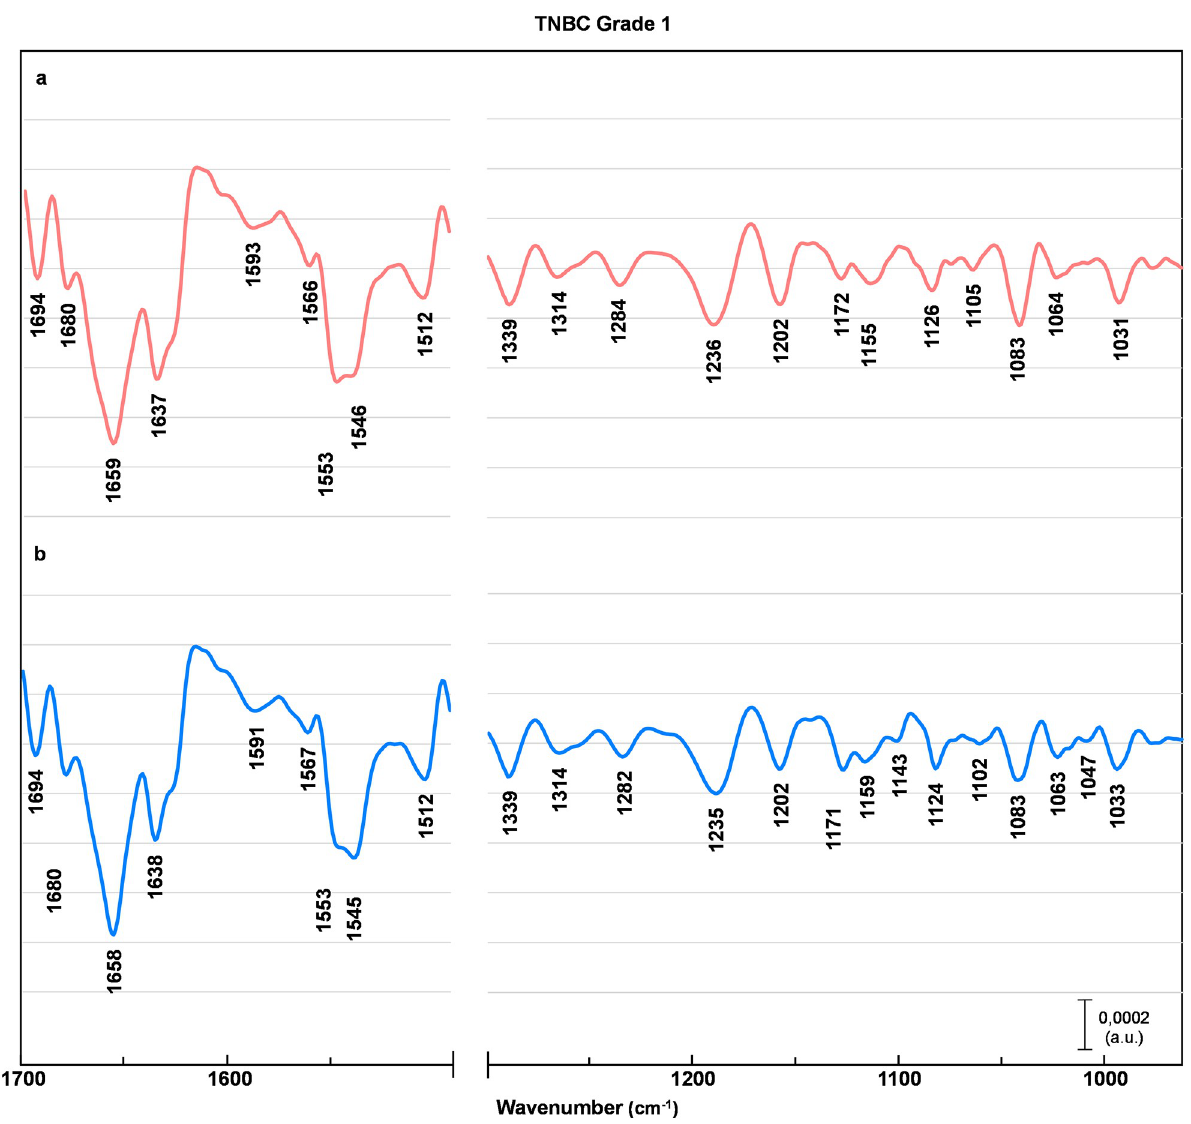
Fig 3. TNBC grade 1 averaged spectra. EMSC-corrected 2nd derivative spectra of TNBC grade 1 breast tissue before (a) and after (b) preoperative chemotherapy with assigned minima.